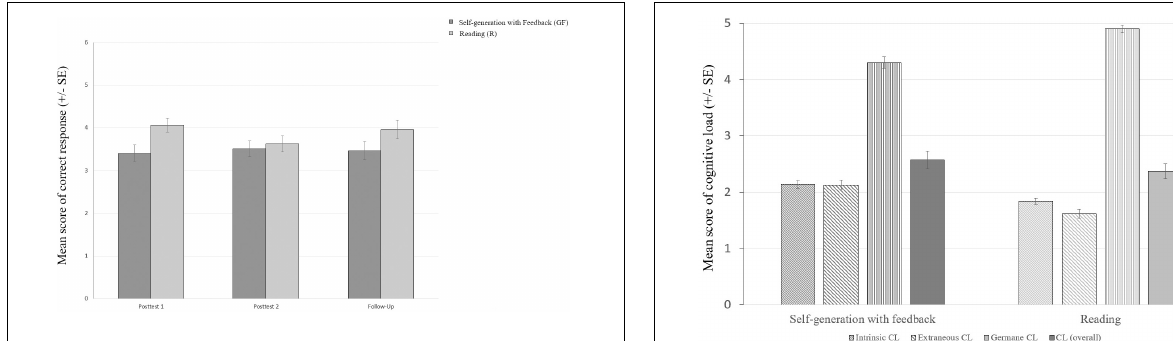
FIGURE 1 | Mean score of correct responses by treatment and time.